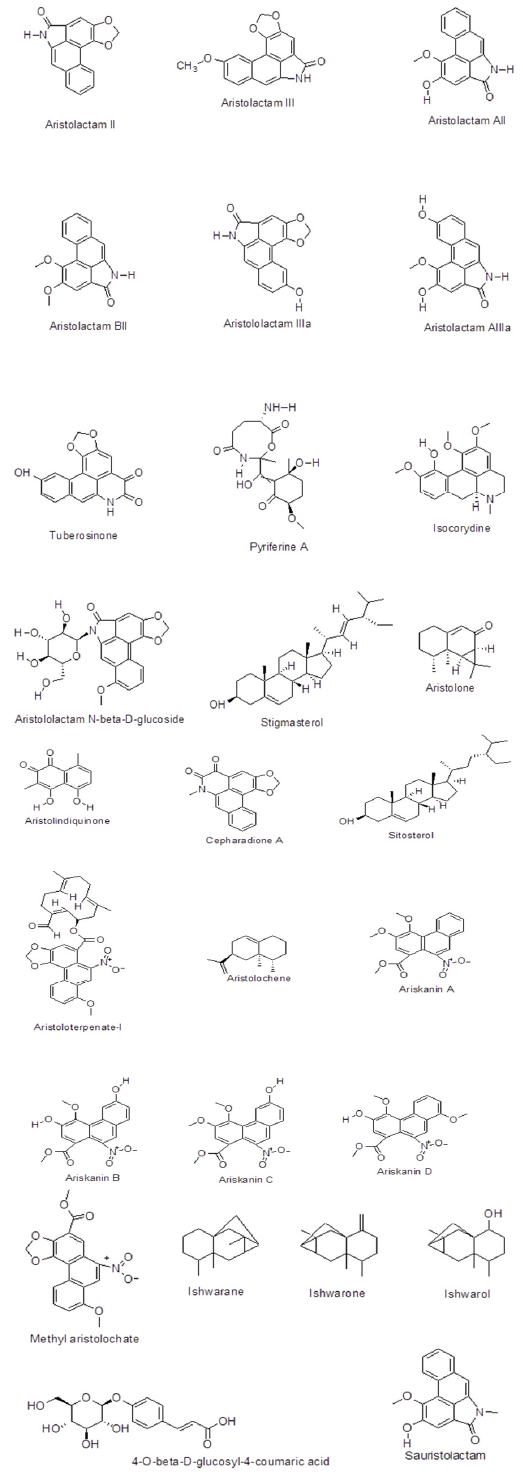
Figure 2. Chemical structures of some important Phyto-constituents of Aristolochia